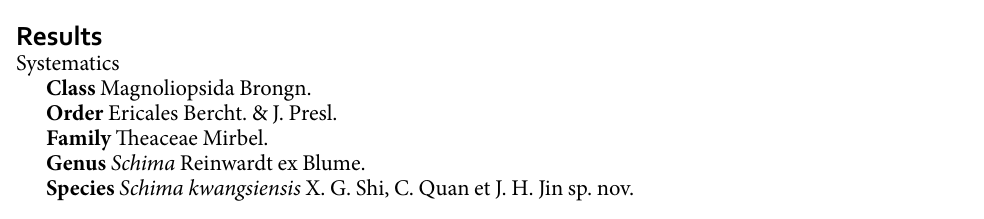
Figure 2. Geographic map of the Nanning Basin, Guangxi Province, generated by X. G. Shi, using Arcgis 9.3 (ESRI, Redlands, CA,